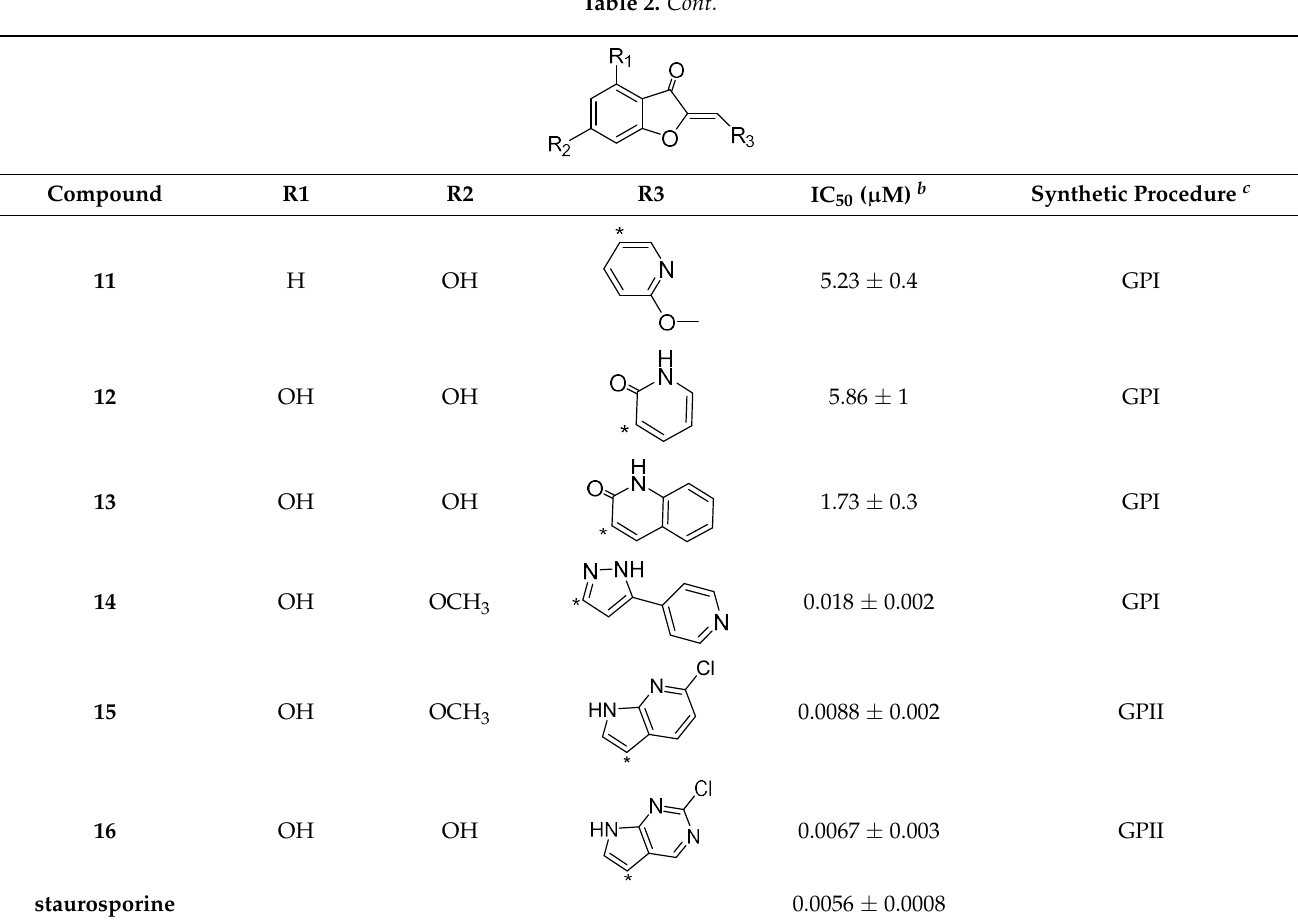
a Asterisk indicates the atom attached to the position of substitution. b Values are given as the mean ± standard deviation of the two experiments. c Synthetic procedures are described in Section 3.4.